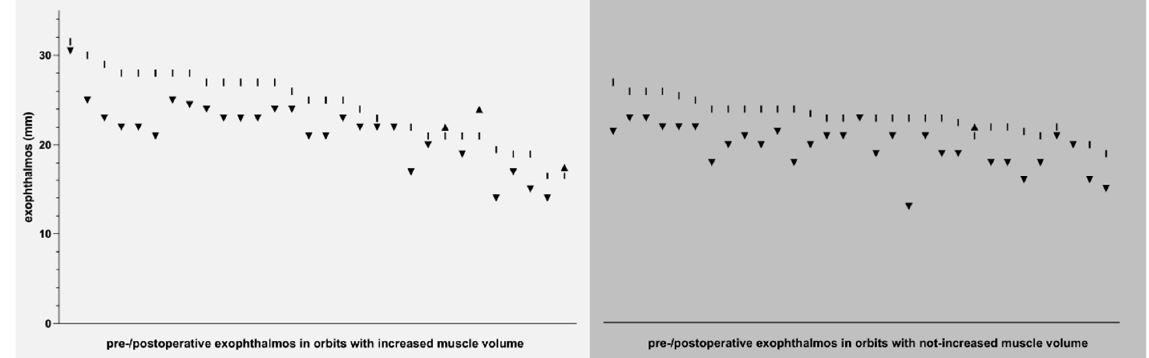
Figure 6. Development of exophthalmos after orbital decompression. y axis = exophthalmos values (in mm) per orbit before and after orbital decompression, x axis = pre-/postoperative exophthalmos values of each orbit in the group with increased orbital muscle volume (left, light gray background) and in the group with not-increased orbital muscle volume (right, medium gray background), ver- tical line = preoperative exophthalmos value per orbit, black triangle (sharp angle downwards) = postoperative decrease in exophthalmos (or stable exophthalmos) per orbit, black triangle (sharp angle upwards) = postoperative increase in exophthalmos per orbit. The 24 orbits in each of the not-increased and the increased group affected by DON also presented a significant reduction in the mean exophthalmos postoperatively com- pared with the corresponding preoperative values (not-increased group: a difference of 3.55 mm ( p < 0.0001); increased group: a difference of 3.13 mm ( p = 0.0309)). In these orbits affected by DON, there were no significant differences between the not-increased and increased group regarding their mean pre- and postoperative exophthalmos values. Further information is given in Table 3. Table 3. Intra- and inter-group statistical analysis of pre- and postoperative exophthalmos (analy- sis within and between “not-increased” and “increased” orbital muscle volume). Not-Increased Muscle Volume